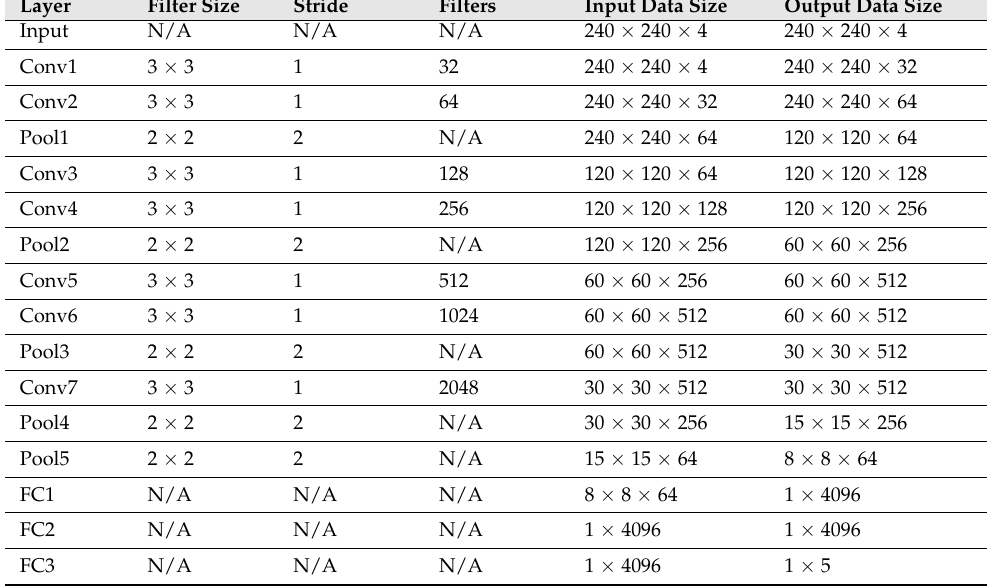
Table 9. Design Architecture of Convolutional and Pooling Layers with